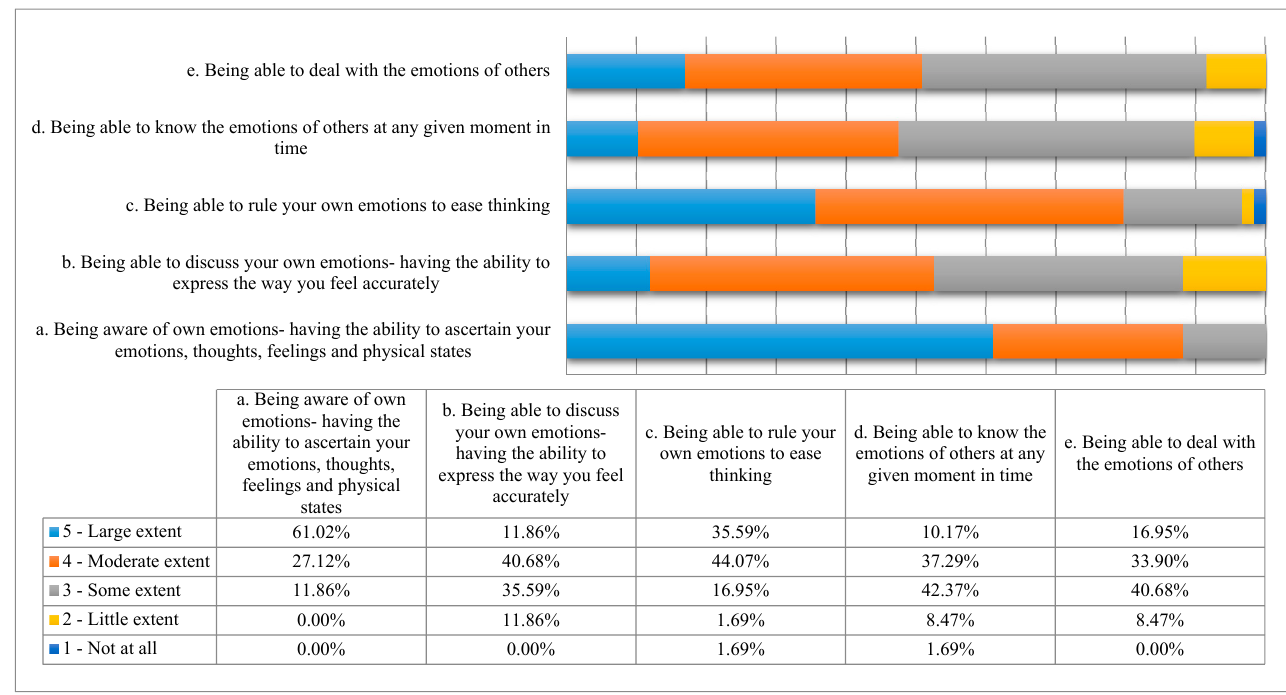
Figure 3. Frequency distribution (%) of the participants’ levels of emotional disposition based on the derived key success factors of emotional intelligence that affect oil and gas workplace performance.